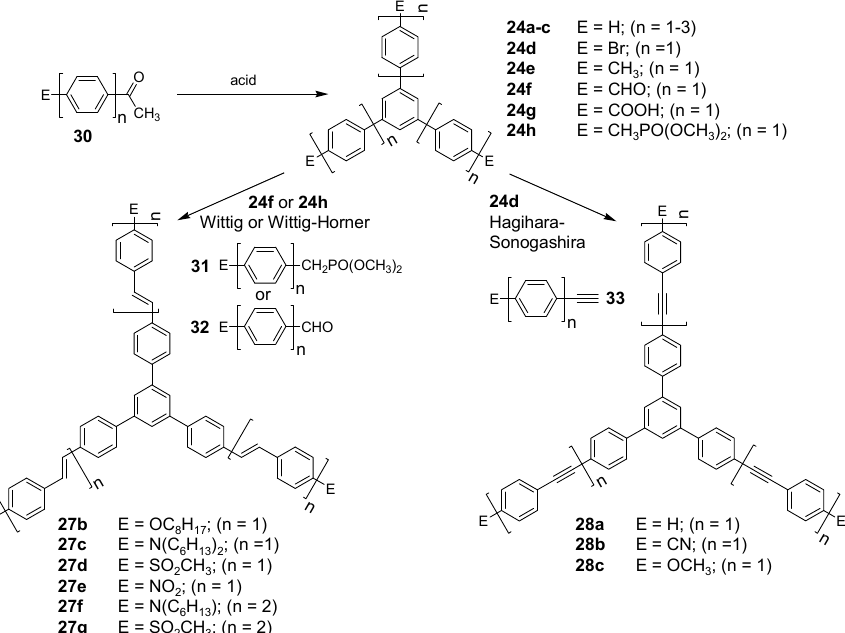
Scheme 8. Preparation of three-arm oligophenylene stars 24 with a benzene core and the related oligo(phenylenevinylene) and oligo(phenylene ethynylene) stars 27 , 28 based on a triphenylbenzene core.